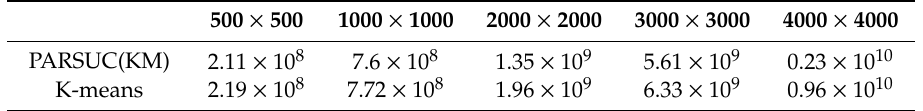
Table 3. Comparison of the clustering accuracy of the sum of squared error (SSE) between (parallel subsampling-based clustering) PARSUC(KM) and conventional K-means.